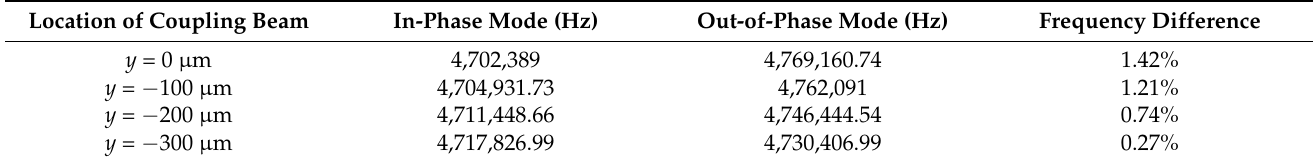
Table 3. The in-phase and out-of-phase mode resonant frequencies of a 2-DoF coupled BAW square plate resonator system with the same mechanical coupling beam located at different positions obtained by FEM simulation in